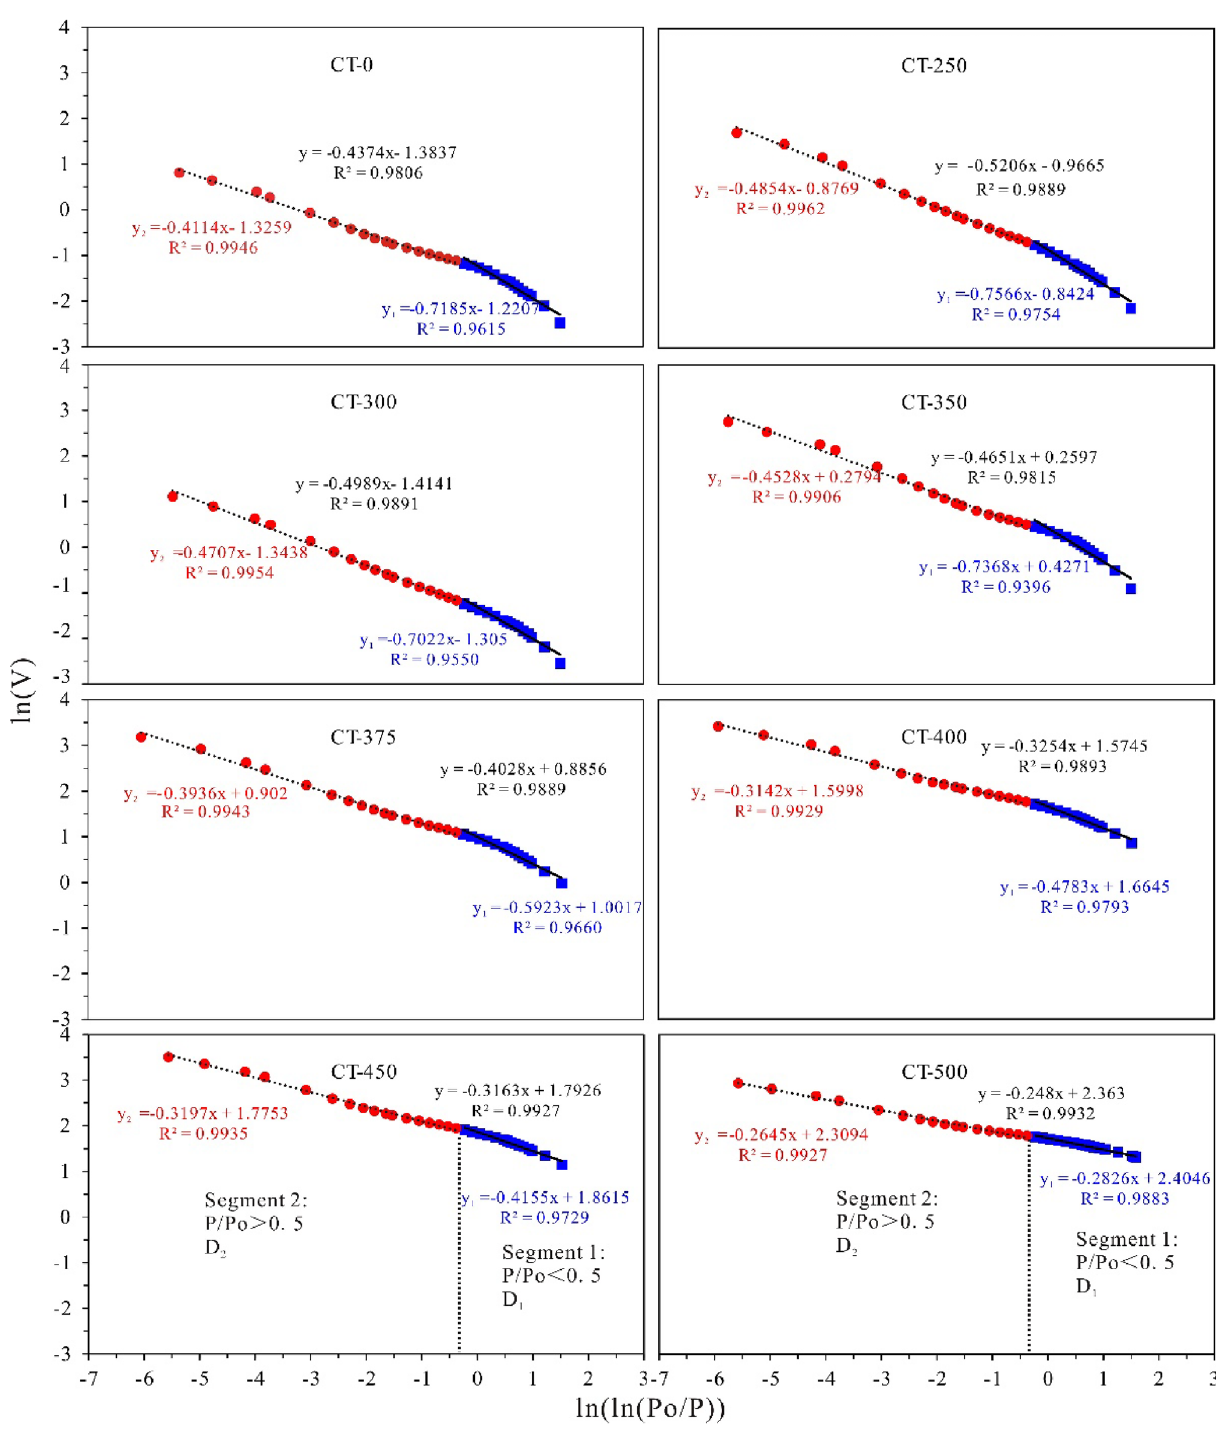
Fig. 2 Plots of ln( V ) versus lnln(Po/ P ) based on the nitrogen adsorp- tion isotherms. CT-0 represents the original sample; CT-250, 300, 350, 375, 400, 450 and 500 represent the different simulation tem-